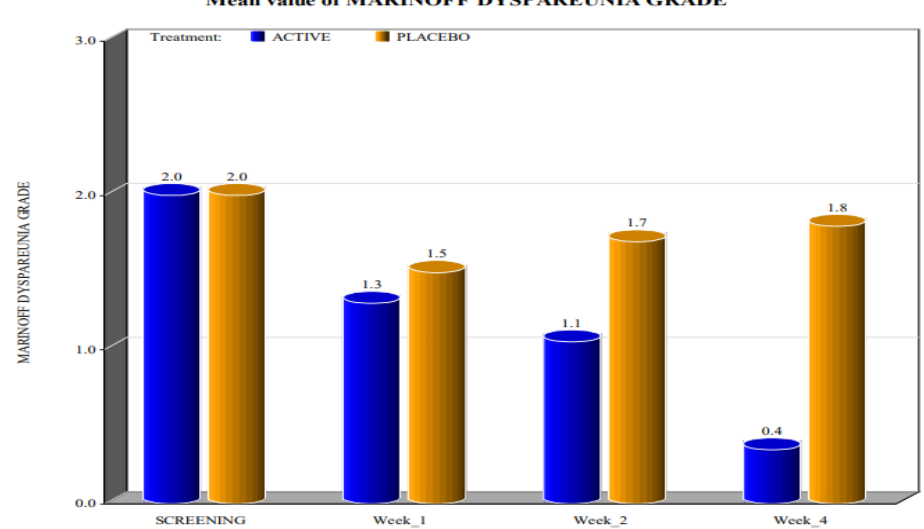
Figure 6. Mean values of the Marinoff dyspareunia grade. ( p value < 0.0001).